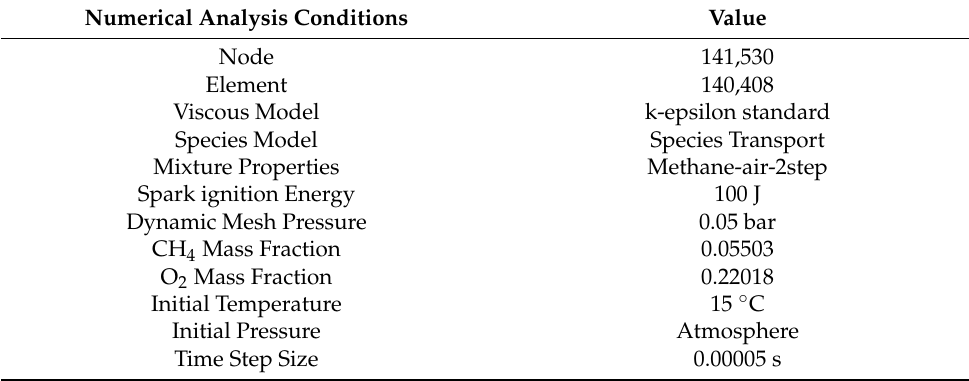
Table 2. Numerical Analysis Conditions.